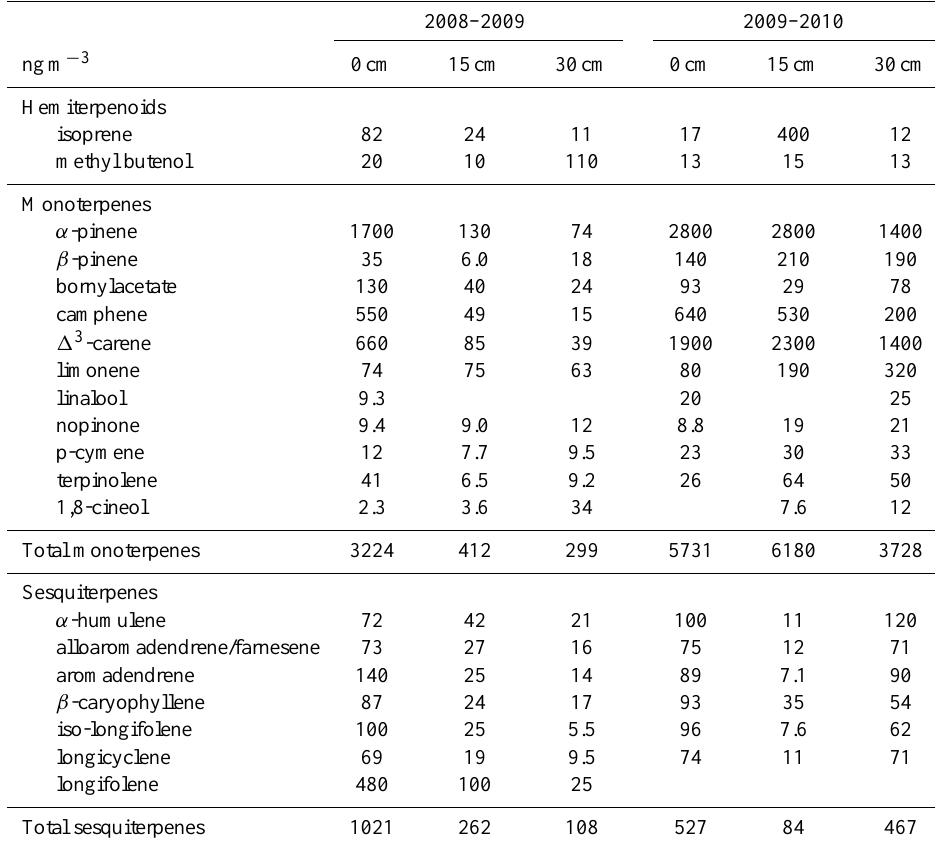
Table 2. Average concentrations of the terpenoids observed in different snowpack profiles ( n = 3) during winters 2008–2009 and 2009–2010, 0cm representing the soil